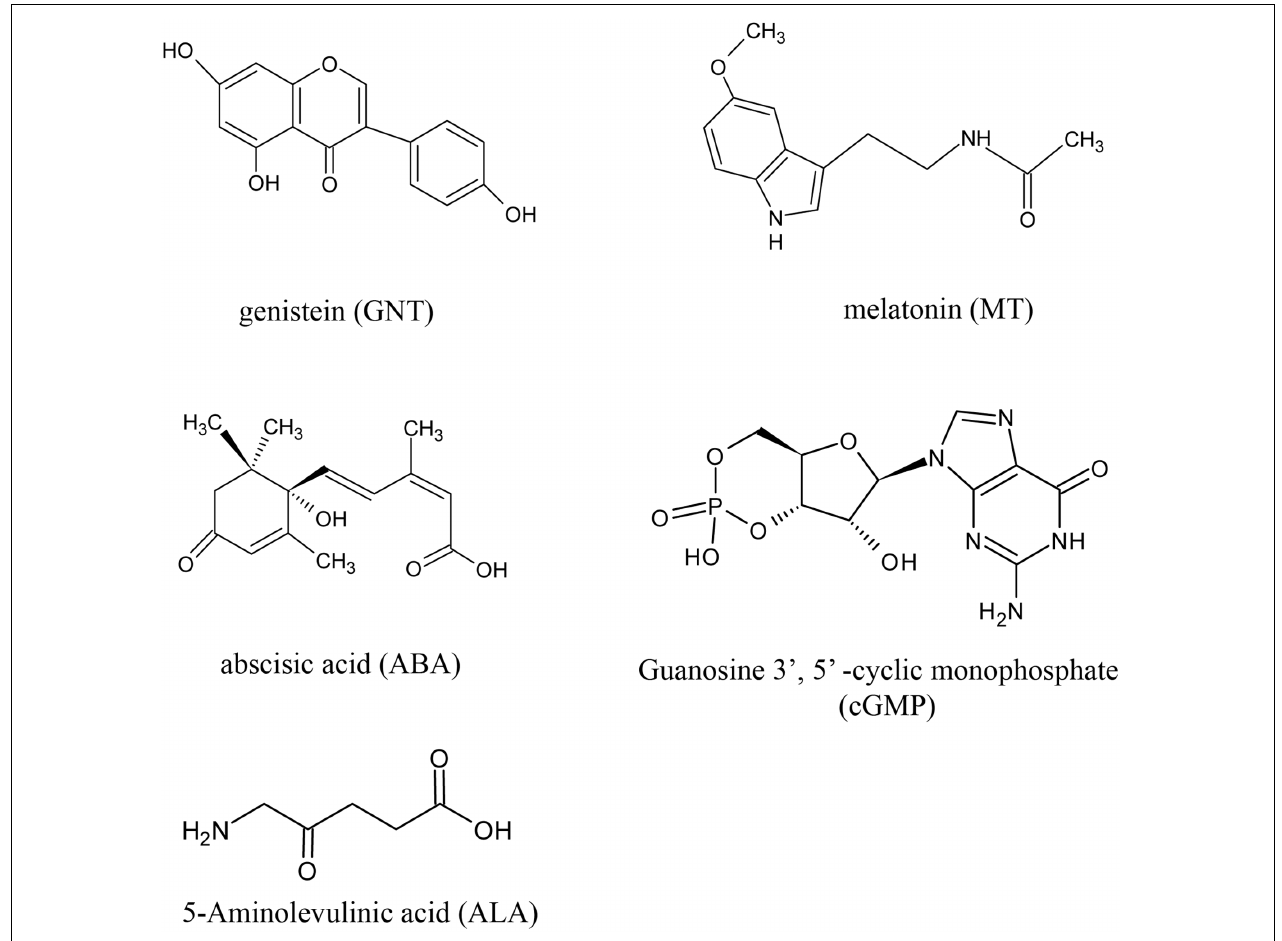
FIGURE 1 | The structure of the chemicals applied to red